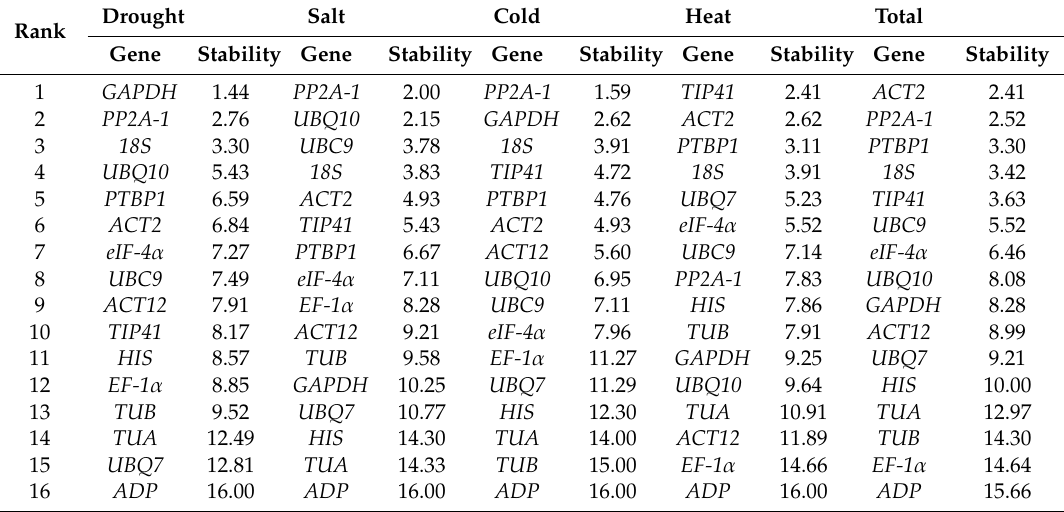
Table 6. Gene expression stability ranked by the comprehensive ranking method in L. olgensis .